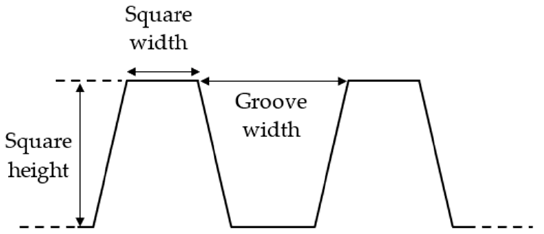
Figure 3. Dimensions of micrometric square pillars textured on the 316L sample.